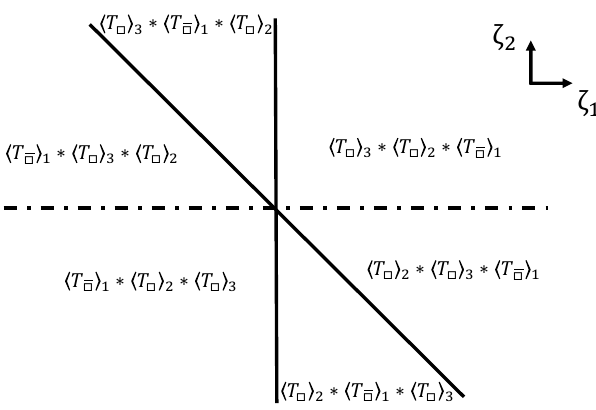
Figure 17 . The relation between the order of the Moyal product and the space of the FI parameters in the case of the v = e N sector. Crossing the solid lines causes a discrete change while no such change occurs across the broken lines. The solid and broken lines separate the plane into six FI-chambers, while the solid ones alone separate the plane into four